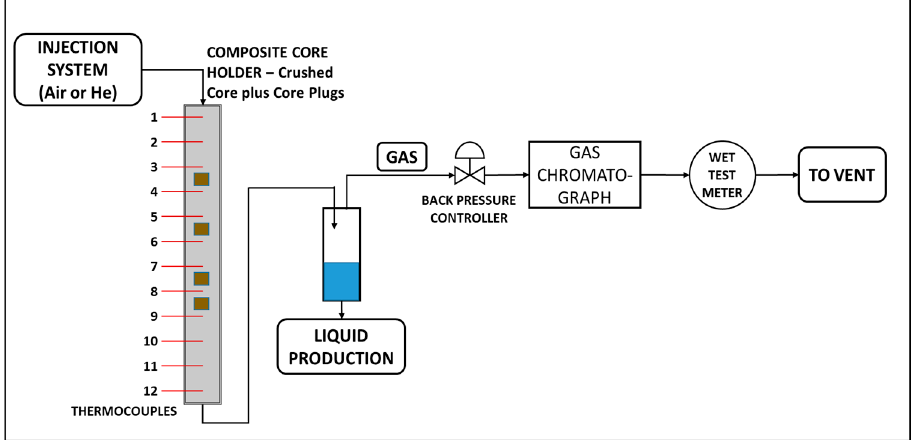
Figure 5. Schematic drawing of the MPCT system showing the location of the four core plugs relative to the 12 centerline thermocouple